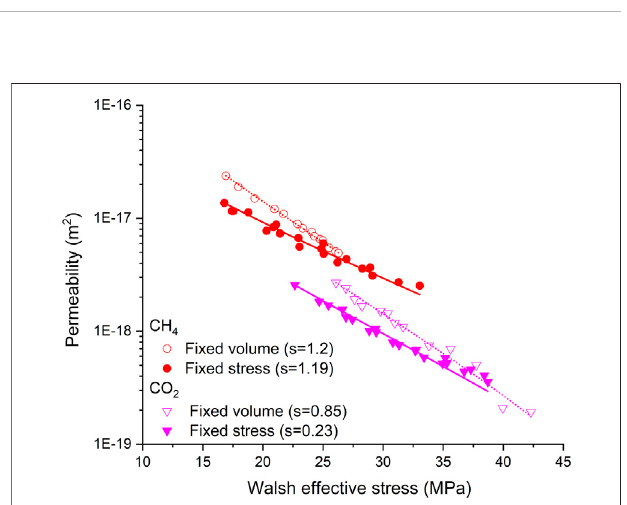
FIGURE 10 | Permeability data obtained from Figure 6 , plotted in logarithms, as a function of the Walsh effective stress. Circle points represent all permeability data for CH 4 shown in Figure 6A , while triangle points represent selected data for CO 2 shown in Figure 6B . Solid and hollow representthe fi xedvolumeand fi xedstressboundaryconditions,respectively. s is the Walsh effective stress coef fi cient, and the lines represent the best fi ttings of Eq. 2 to the data points. The values of σ the parameter values obtained are listed in Table 3